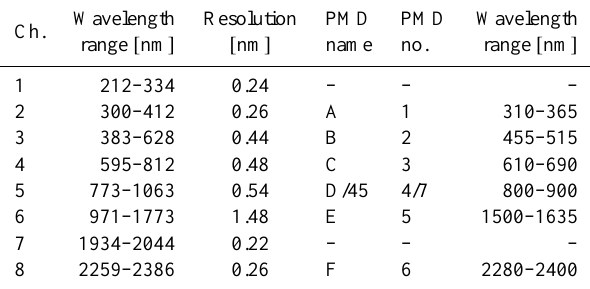
Table 1. Spectral characteristics of the science channels and the PMDs. The name of the PMDs is used in many SCIAMACHY doc- uments, in this paper the number is used. The PMD wavelength range is defined such that it contains 80% of the signal, the range of the science channels is the total